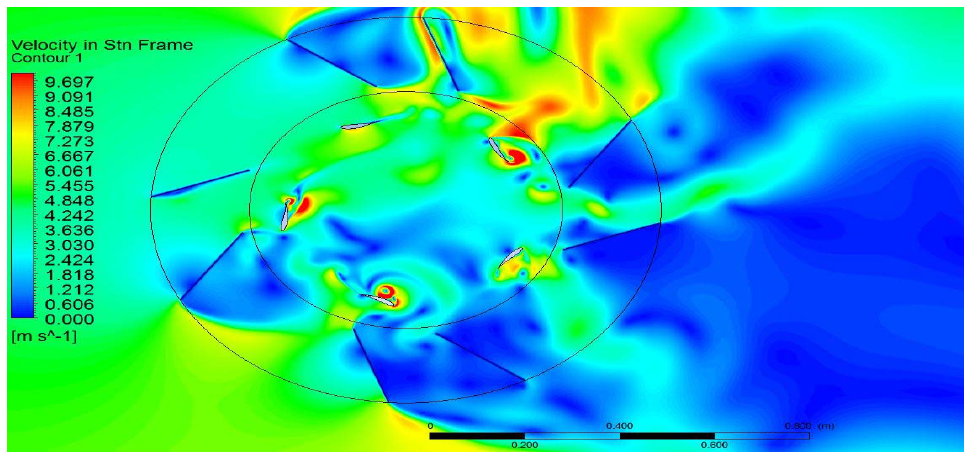
Figure 31. Contour of velocity magnitude for augmented rotor.